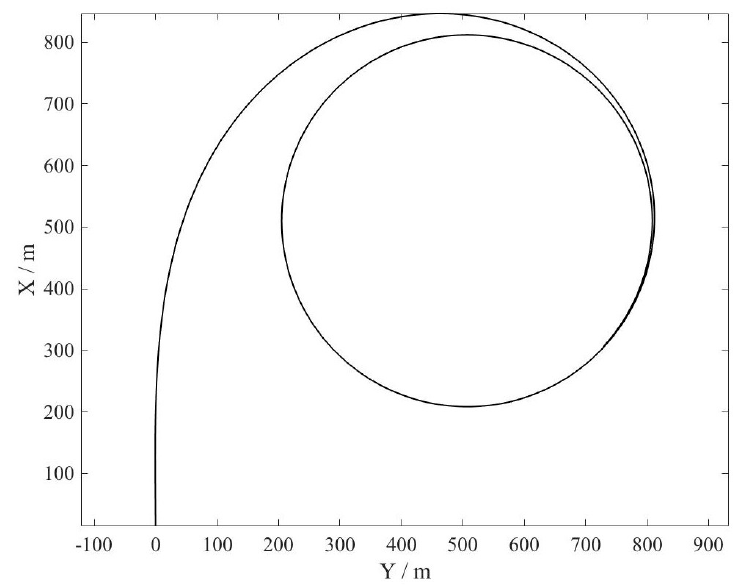
Figure A2. Turning circle at maximum rudder angle (digital MMG model).